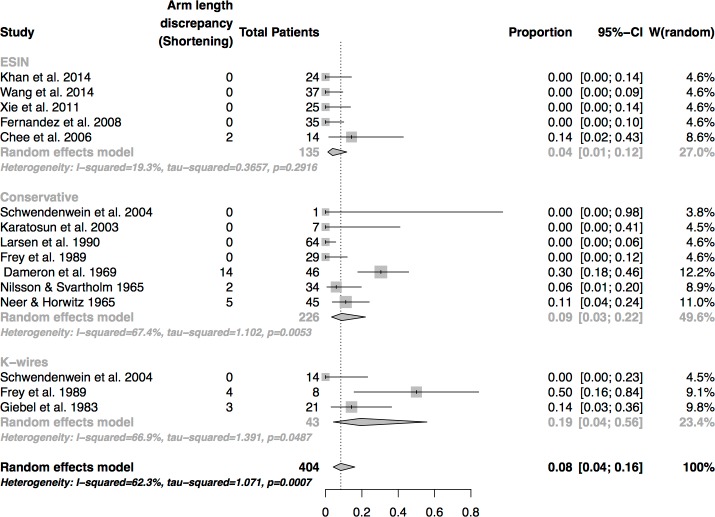
Analysis of arm length discrepancies at final follow-up.